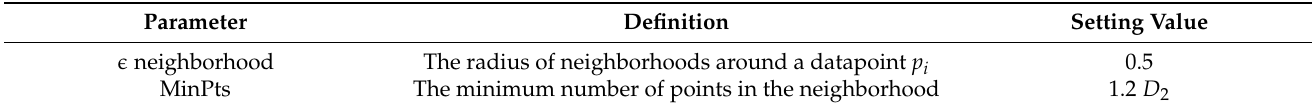
Table 1. Parameter value interpretation and setting.